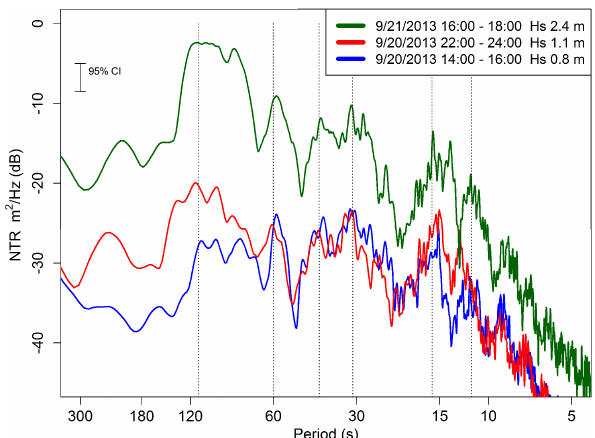
Figure 6. Power spectral density estimates of 1Hz nontide resid- ual over 2h periods during 20 and 21 September 2013 with differ- ent deep water wave heights. Dotted vertical lines mark the harbor modes at 112, 60, 41, 31, 16 and 12s.